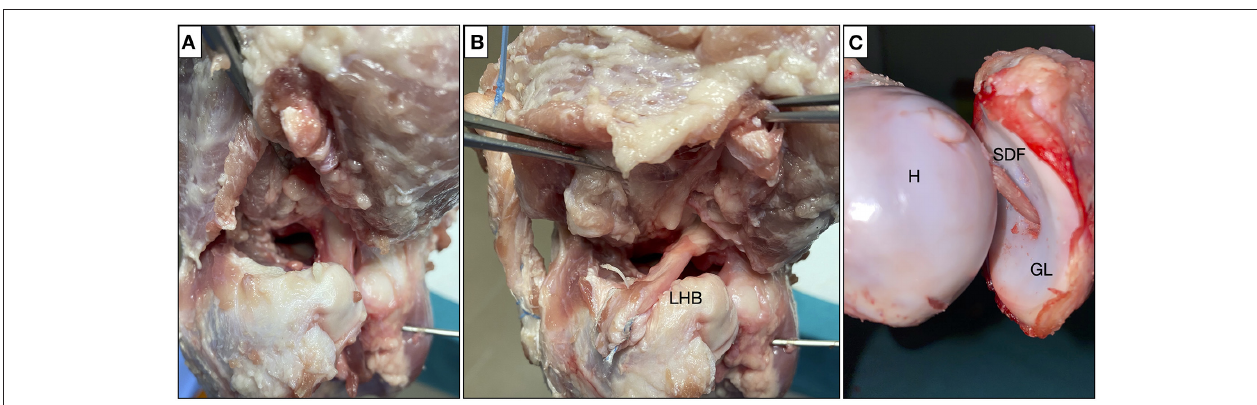
FIGURE 2 | Testing scenario: (A) complete tear of the supraspinatus; (B) SCR with ABC technique; and (C) stabilization with the AISS technique. SCR, superior capsular reconstruction; ABC, Arthroscopic Biceps Chillemi; AISS, arthroscopic intra-articular stabilization of the shoulder; LHB, long head biceps tendon; SDF, superficial digital flexor tendon; H, humerus; GL,